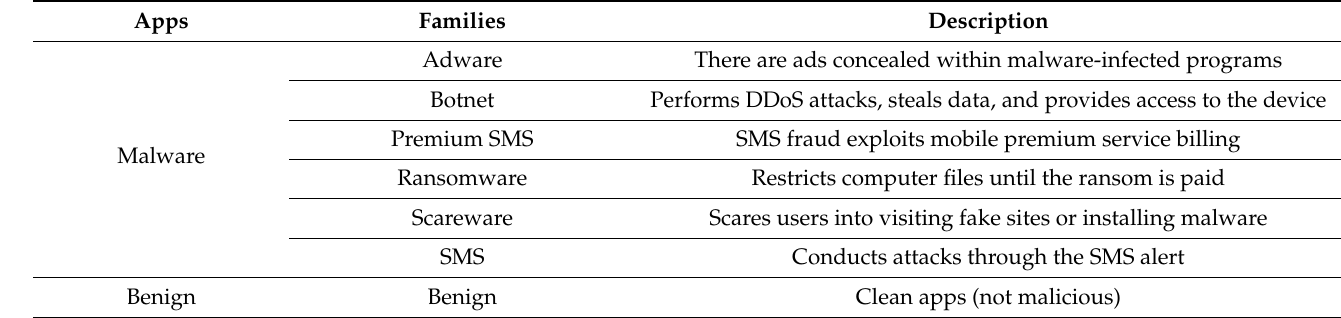
Table 1. CIC-InvesAndMal2019 dataset (dataset 1).